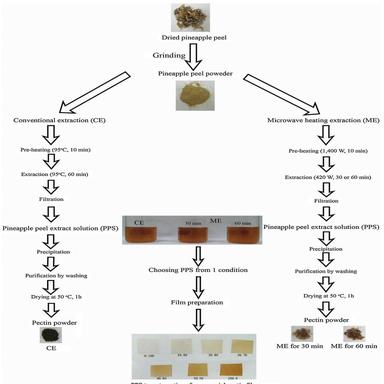
Flow diagram of pectin extraction from pineapple peel using conventional (CE) and microwave (ME) heating and the selected pineapple peel extract solution (PPS) used as a solvent to form pectin films.